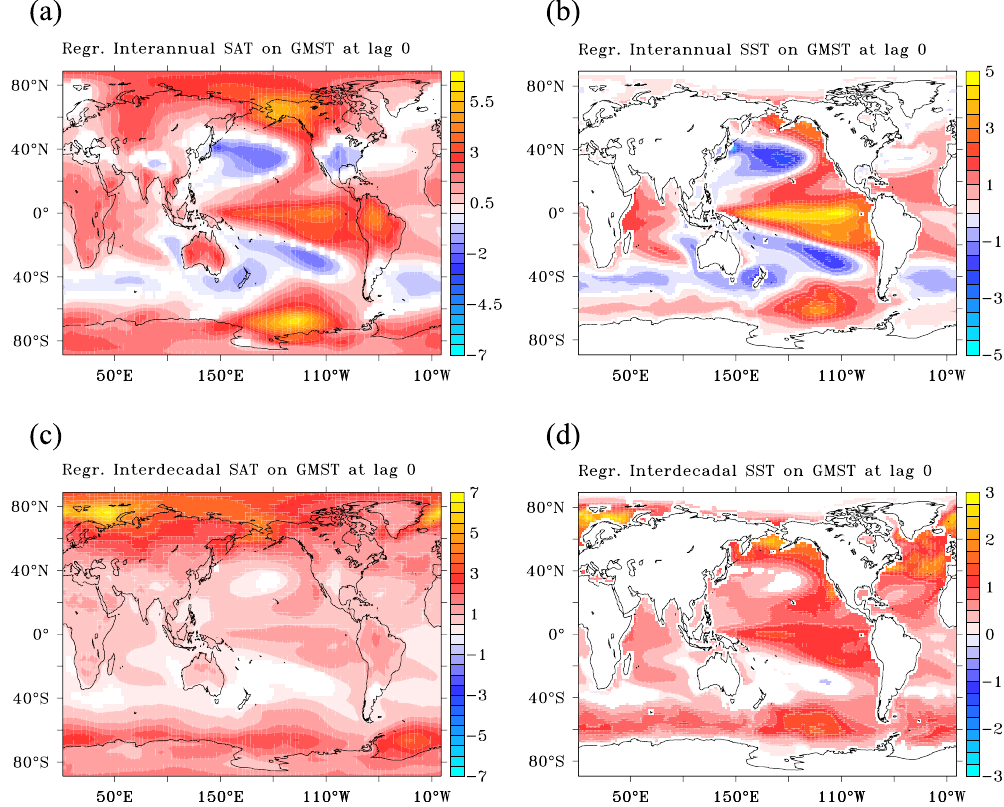
Figure 6. The temperature patterns during an inter-annual and decadal GMST anomaly. ( a – d ) Regression on GMST at lag 0. The regression of surface air temperature (K K − 1 ) ( a , c ), and of sea surface temperature (K K − 1 ) ( b , d ). Only significant values using 95% confidence intervals are shown. This figure has been created with the free Ferret software package developed by the National Oceanic and Atmospheric Administration (NOAA) and available from